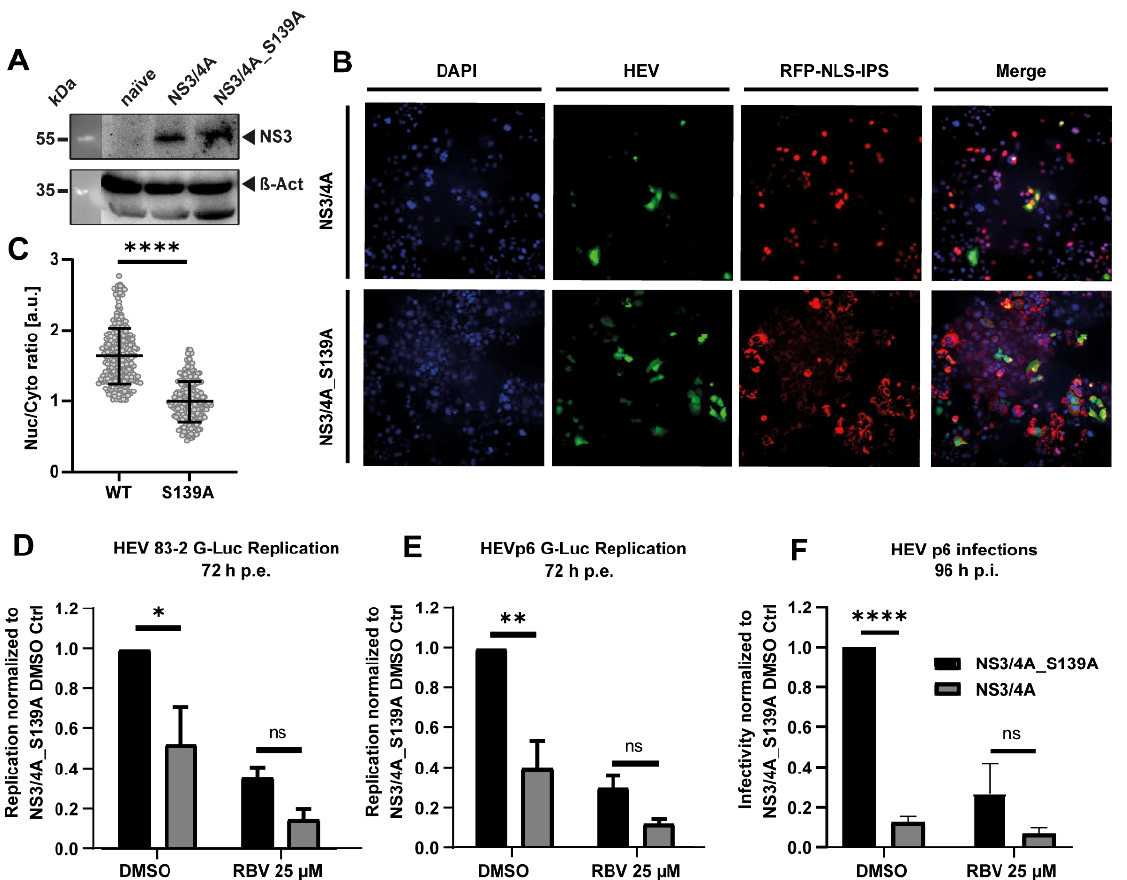
Figure 4. HEV replication after ectopic HCV protease NS3/4A expression. ( A ) Western blot of Huh7.5 cells overexpressing NS3/4A or NS3/4A_S139A. ( B ) Representative IF pictures of